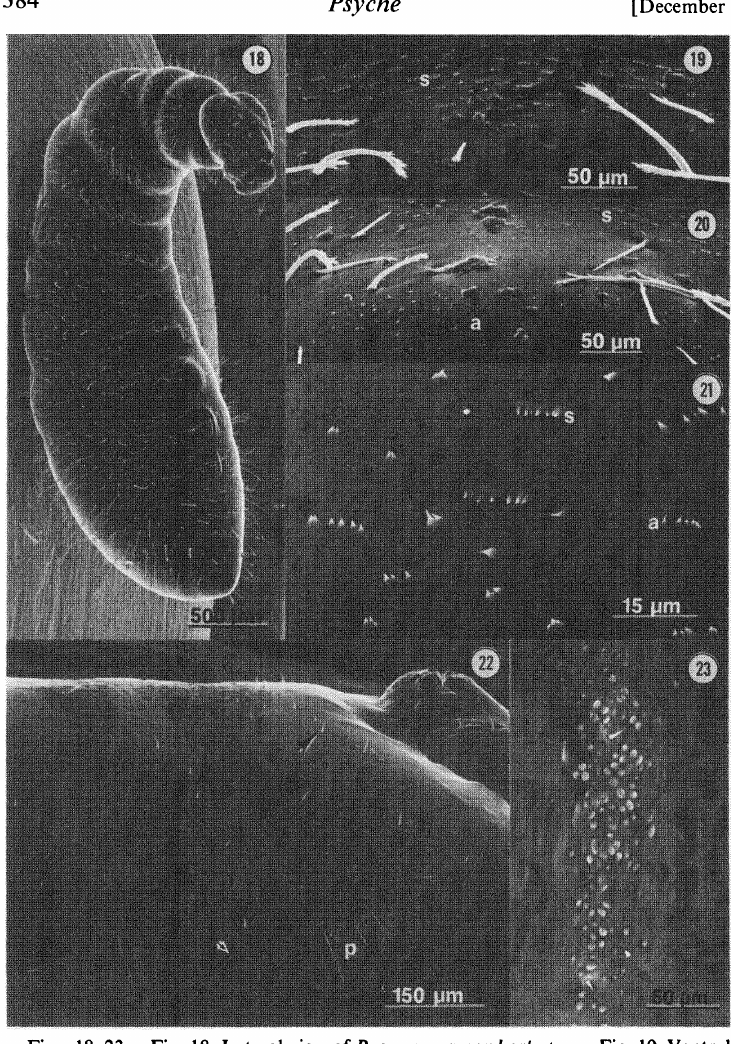
Figs. 18-23. Fig. 18. Lateral view of Pogonomyrmex barbatus. Fig. 19. Ventral region of 2nd abdominal segment of P. barbatus. Note rows of posteriorly pointing, anterior spinules (s). Fig. 20. Ventral region of 3rd abdominal segment of P. barba- tus. Note rows of posteriorly pointing, anterior (s) and anteriorly pointing, posterior (a) spinules. Fig. 21. Anteriorly (a) and posteriorly (s) pointing spinules on ventral region of 4th abdominal segment of P. barbatus. Fig. 22. Anteroventral region of Crematogaster laeviuscula, showing hairs (large arrow), papillae (small arrow), and pleats (p). Fig. 23. High magnification of papillae of C.